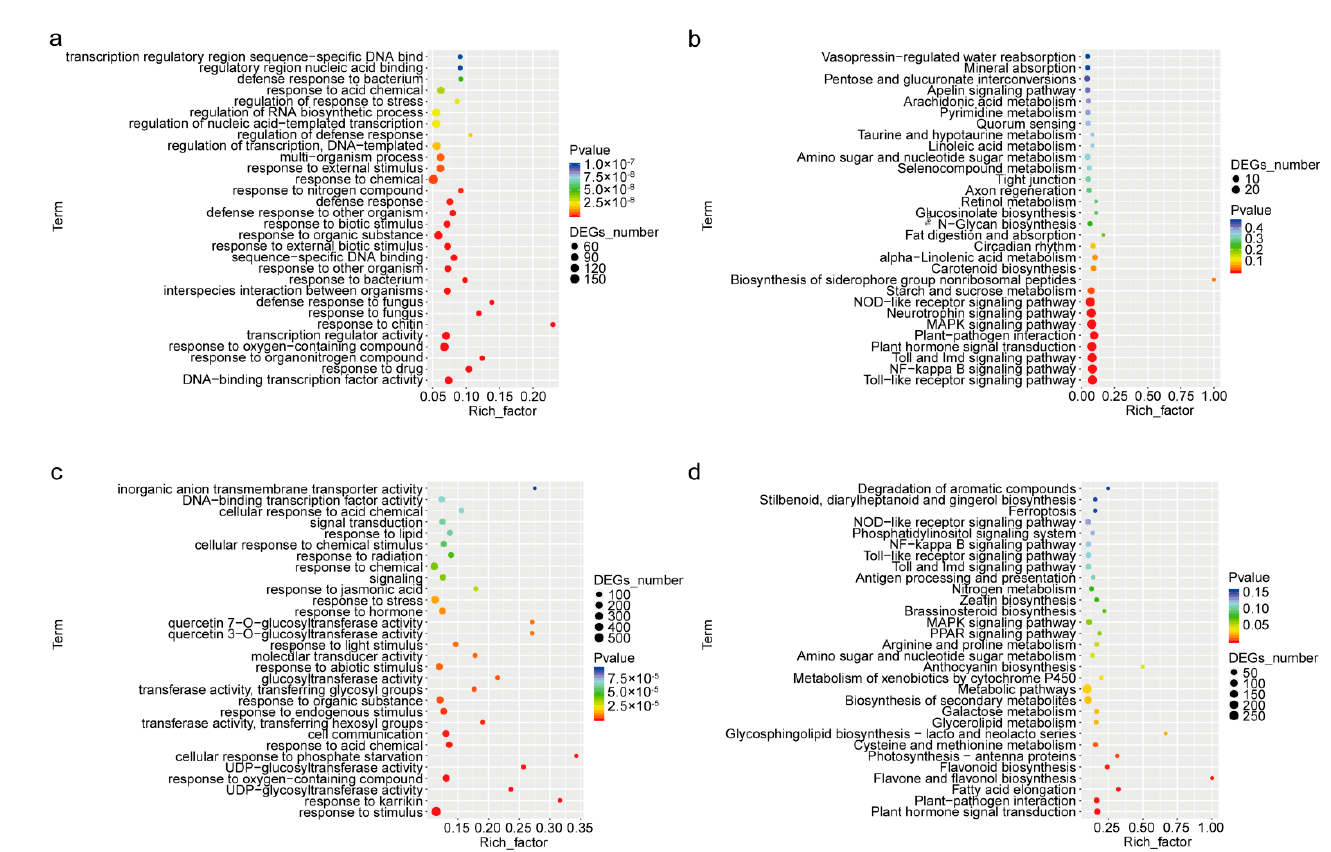
Figure 7. Function enrichment analysis of black and blue module genes. ( a ) GO enrichment map of black module genes. ( b ) KEGG enrichment map of black module genes. ( c ) GO enrichment map of blue module genes. ( d ) KEGG enrichment map of blue module genes.